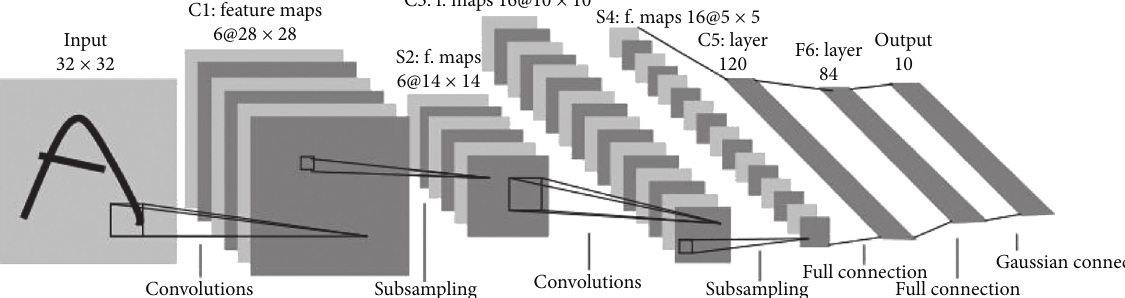
Figure 1: The network structure of Lenet.